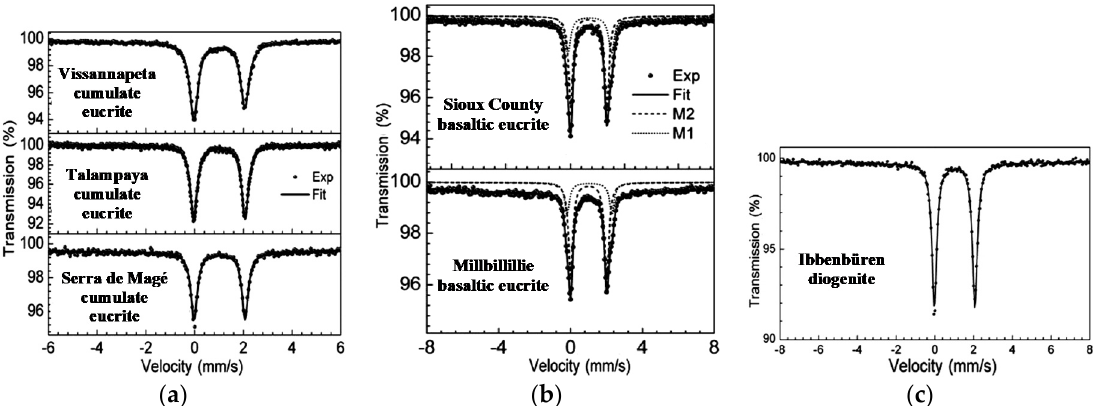
Figure 6. Comparison of the room temperature Mössbauer spectra of cumulative eucrites ( a ), basaltic eucrites ( b ), and diogenite ( c ). Adapted from [20].